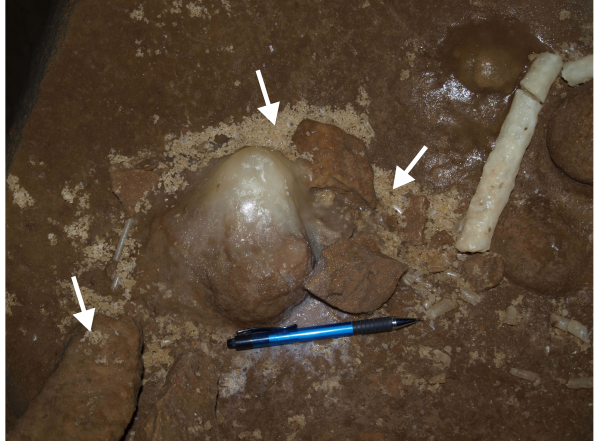
Fig. 3. “Crystal sand” on collapse block (arrows) in the R¨atselhalle.